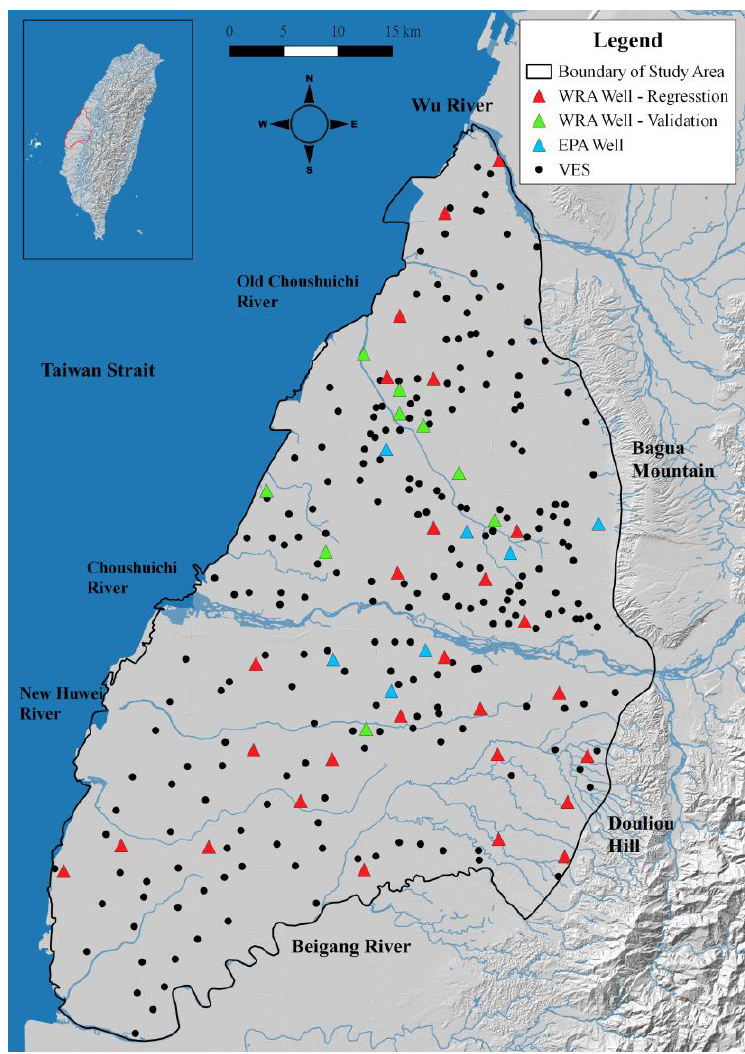
Figure 1. Location of the study area with the distributions of observation wells and vertical electrical sounding measurements.